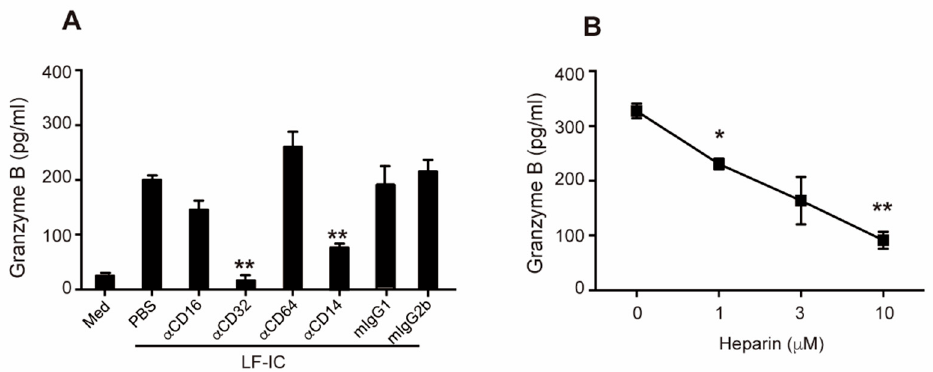
Figure 4. Crosslinking of Fc γ RIIa and membrane-bound CD14 was essential for the tumoricidal activity empowerment to monocytes by LF-IC. ( A ) Freshly isolated human monocytes were primed with 30 µ g / mL LF-IC for 48 h in the presence of 5 µ g / mL α CD16, α CD32, α CD64 or α CD14. mIgG1 and mIgG2b were included as isotype controls. ( B ) Monocytes were primed with 30 µ g / mL LF-IC for 48 h in the presence of di ff erent concentration of heparin. GzB in supernatant was determined by ELISA. * p < 0.05, ** p < 0.01, *** p < 0.001.